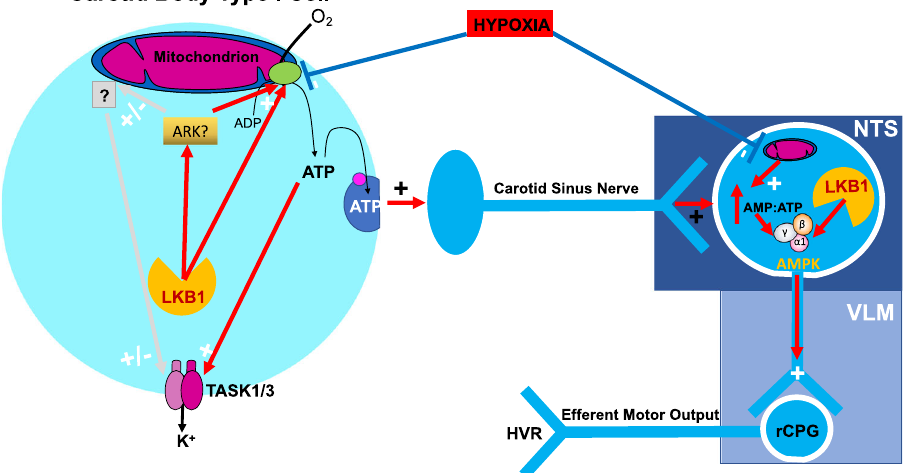
Fig. 9 Graphical abstract showing the divergent pathways by which LKB1 and AMPK may coordinate the hypoxic ventilatory response. LKB1 liver kinase B1, AMPK AMP-activated protein kinase, ARK AMPK-related kinase, NTS nucleus tractus solitarius, VLM ventrolateral